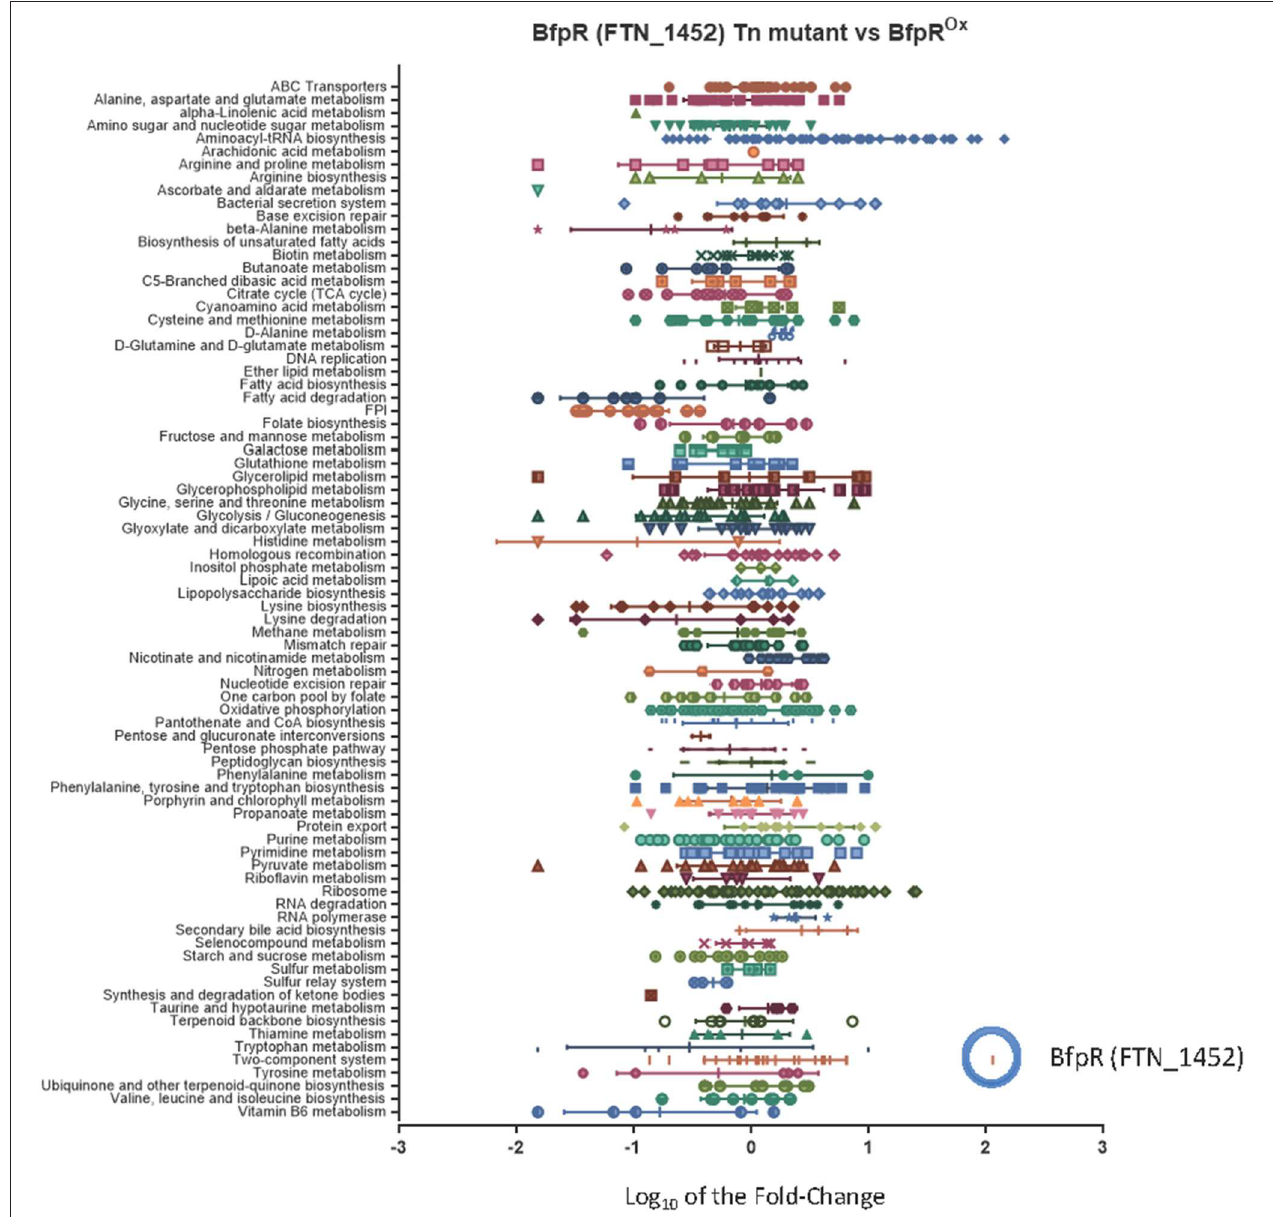
FIGURE 4 | Characterization of the bfpR regulon. The categorization of the bfpR regulon by mapping the RNASeq fold-change data to KEGG Pathways, with the addition of the Francisella Pathogenicity Island (FPI). The graph illustrates the RNASeq results for Log 10 fold-change in expression comparing bfpR Tn-mutant (FTN_1452 Tn-mutant) and bfrR ox mutant. The change in expression of bfpR gene in the overexpressor (blue circle) was one of the most significant with a log 10 fold change for bfpR of 2.06 (114 fold change, Table S3 , Figure S2B ). The FPI gene cluster is indicated with the blue